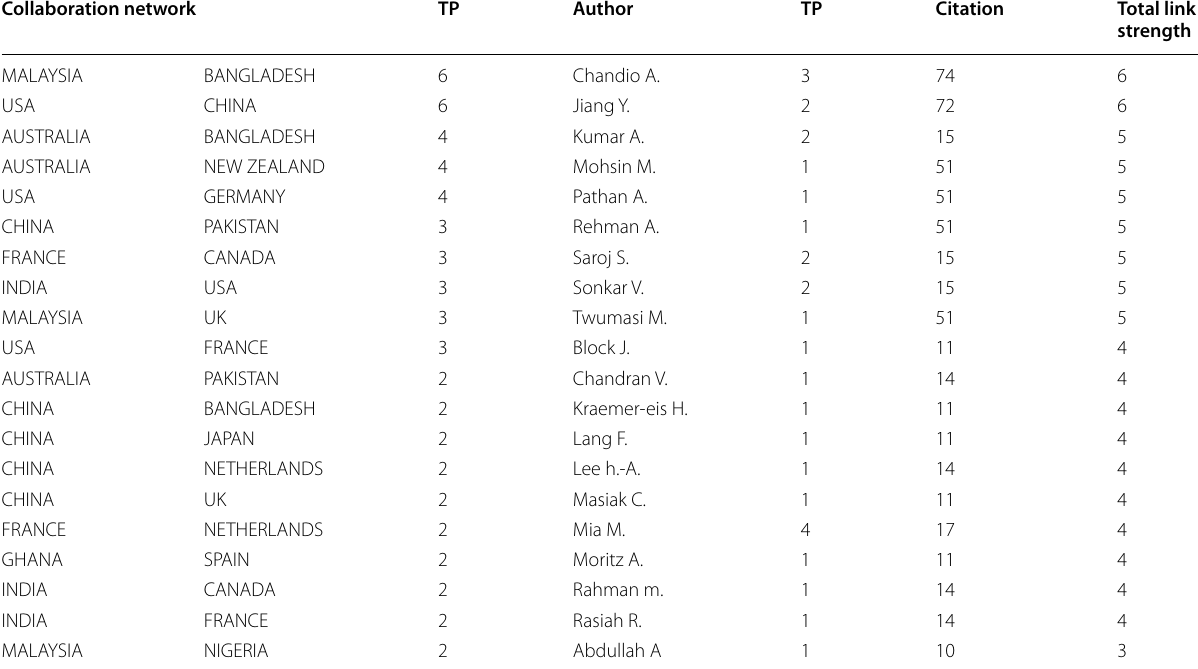
Table 7 Top collaborating countries and